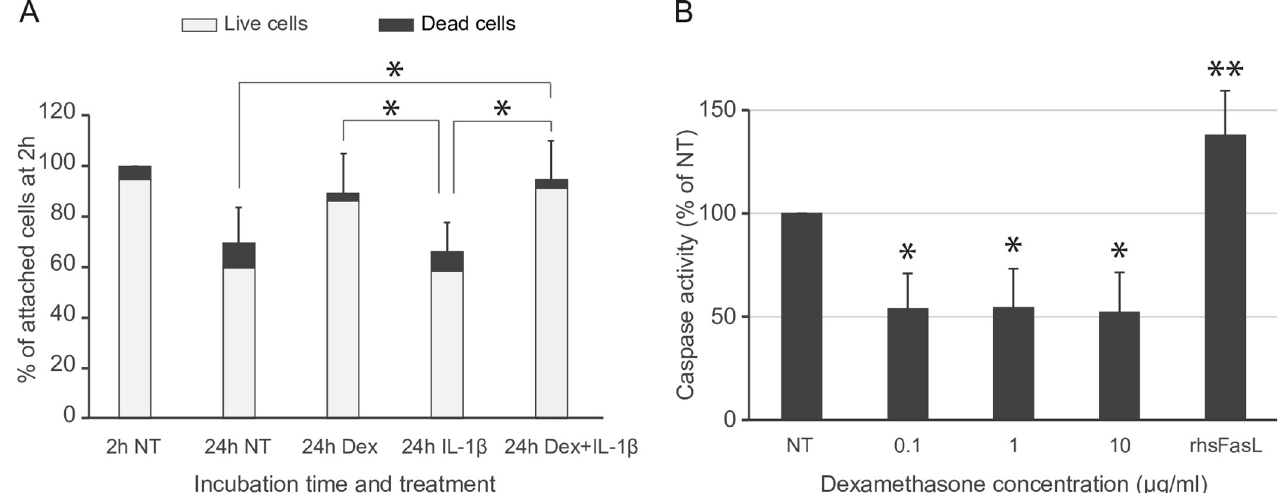
Fig 8. Effect of Dex on LSEC viability in culture. (A) Freshly isolated rat LSECs were seeded in similar densities and cultured for the indicated time points in 5% O 2 and 5% CO 2 in DMEM with serum-free supplements ± 1 μ g/ml Dex, and/or 100 U/ml IL-1 β . Cell viability was measured with a Live/Dead Cell Imaging Kit (Thermo Scientific) as described in Material and Methods. Results are presented as % of attached cells at 2 h (set as 100%) and are the average of 3 biological replicates. Error bars show SD. � Significant between groups (One-way ANOVA, Tukey HSD posthoc test, p < 0.05). (B) LSEC cultures were incubated with 0, 0.1, 1, or 10 μ g/ml Dex for 24 h. Recombinant human Fas Ligand protein (rhsFasL, 100 ng/ml) was used as positive control and added to non-treated cultures 4h before the end of incubation time. Caspase 3/7 activity is shown in percent of the activity in non-treated LSECs without rhsFasL. Results are mean of 4 biological replicates; error bars show SD. � Significantly different from non-treated cultures and cultures with rhsFasL, �� significantly different from non- treated cultures (one-way ANOVA, p <